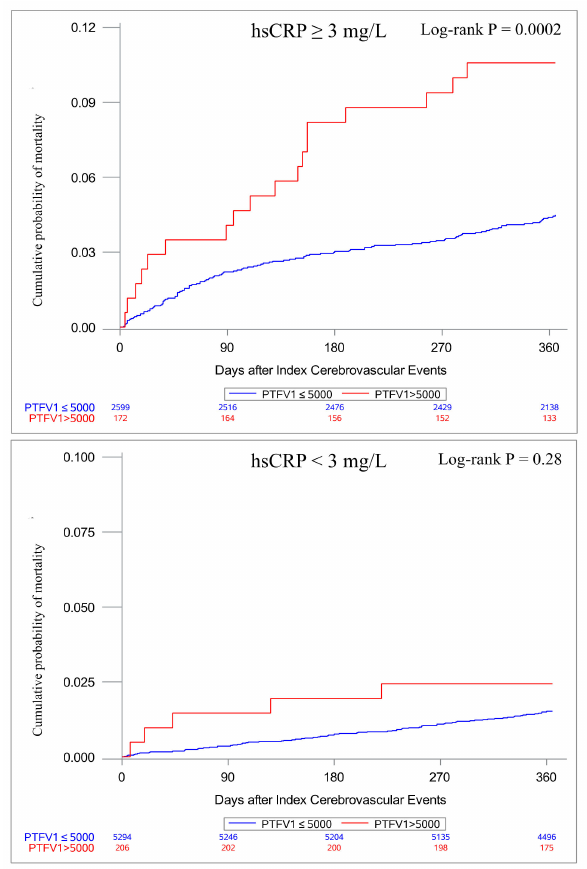
Figure 1. Kaplan–Meier curves for probability of mortality classified by hsCRP level. hsCRP, high- sensitivity C-reactive protein; PTFV1, P-wave terminal force in lead